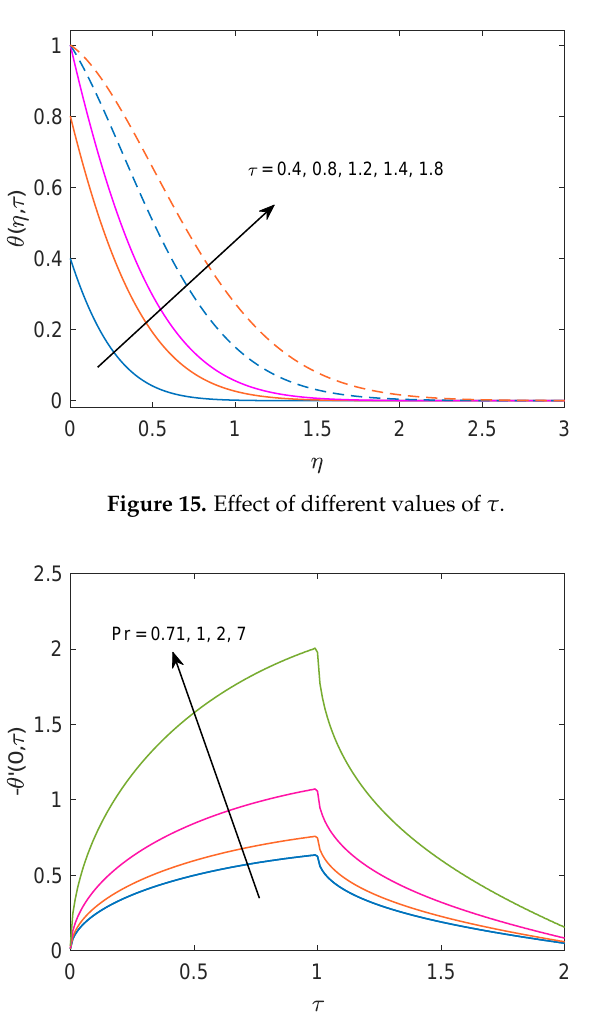
Figure 16. Nusselt number for different values of